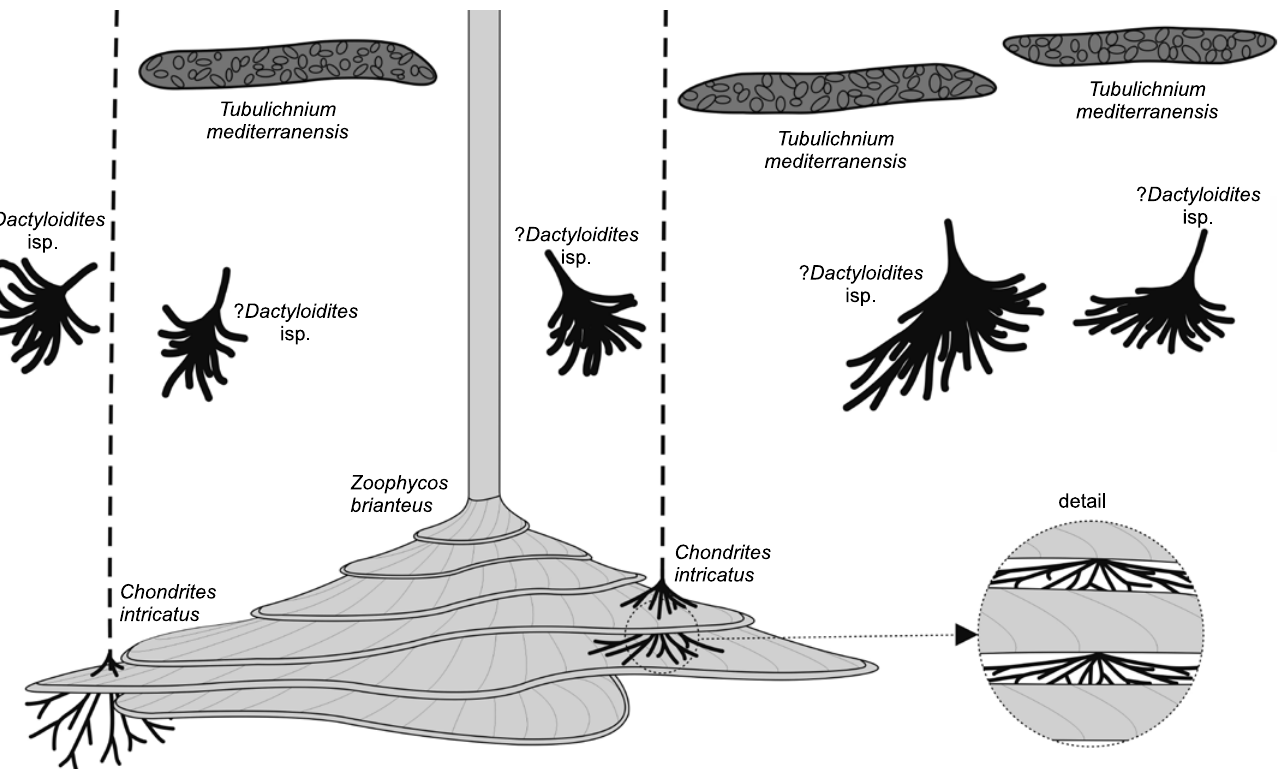
Fig. 9. Tiering of the Zoophycos Bed at Velká nad Veličkou, Czech Republic, Eocene. Upper tier dominated by Tubulichnium mediterranensis , mid-tier dominated by ? Dactyloidites isp., lower tier dominated by Zoophycos brianteus and interacting nucleocave Chondrites intricatus